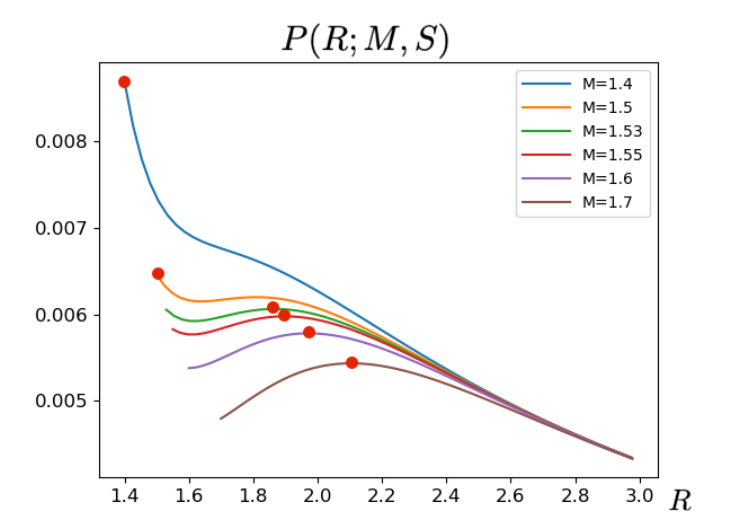
Figure 1. Plots of agent’s expected profit ratio P ( R ; M , S ) as a function of R for fixed lognormal distribution parameters of µ = 0.033 and σ = 0.2, and S = 1.01 and various values of M . Note that when M is low, e.g., M = 1.4, the agent’s optimal decision (that is, the maximizer of the corresponding trace on the chart, marked approximately by the red discs) is R ∗ ( M , S ) = M . However, increasing M has the tendency to “pull down” the left-hand end of the trace. When M ≈ 1.5, this gives rise to a local maximum in the profit function away from R = M ; around M ≈ 1.53, this local maximum becomes the global maximum and the agent’s optimal collateral ratio “snaps” to the right, yielding R ∗ ( M , S ) > M